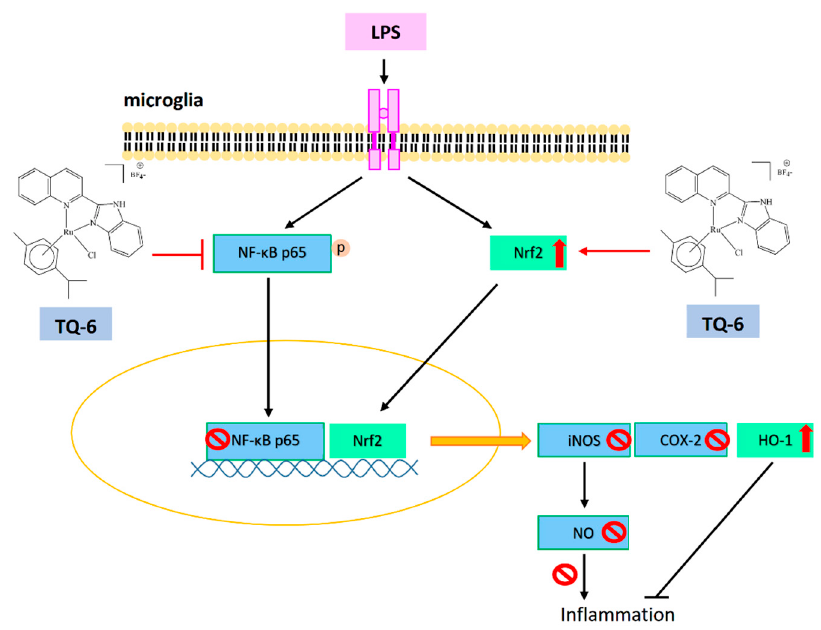
Figure 3. TQ-6 effectively reduced inflammatory mediators NO, iNOS, COX-2 and NF- κ B p65 phosphorylation and its nuclear translocation in LPS-stimulated microglia. TQ-6 increased the expression of nuclear factor erythroid 2-related factor 2 (Nrf2) and hemeoxygenase-1(HO-1).